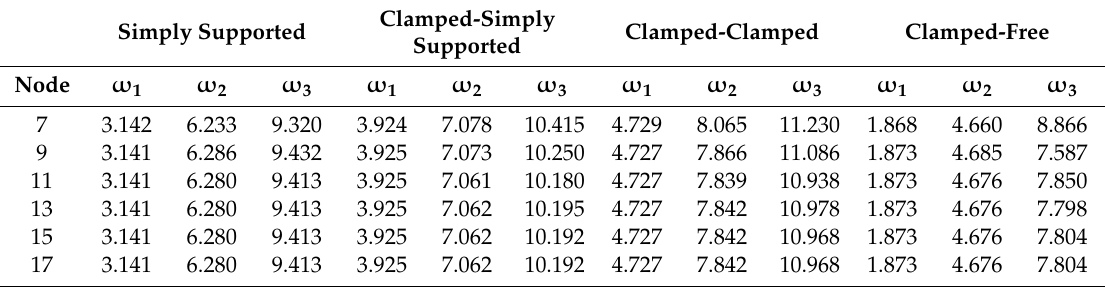
Table 2. Convergence analysis of the size-dependent triclinic beam model ( L / h = 100, l = µ = 1 nm 2